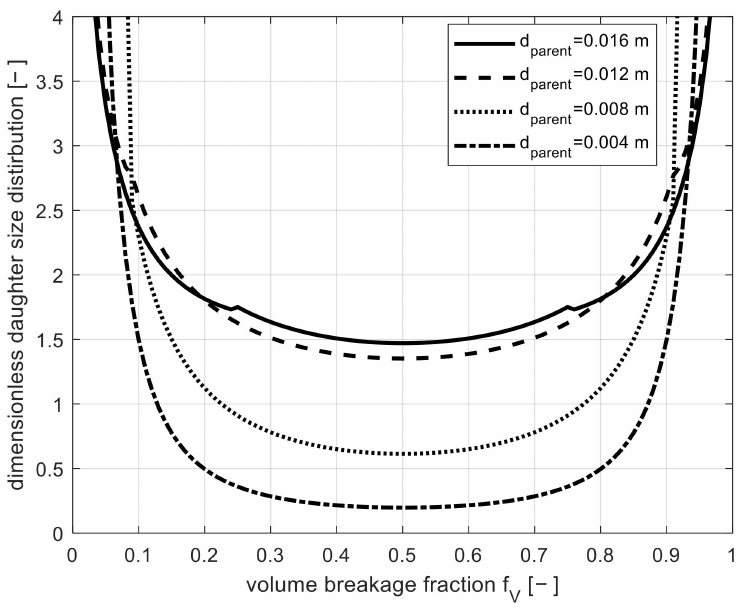
Figure 4. Prediction of daughter size distributions using the approach of Luo et al. for different parent bubble sizes with the set value ε = 0.08 W m − 3 .